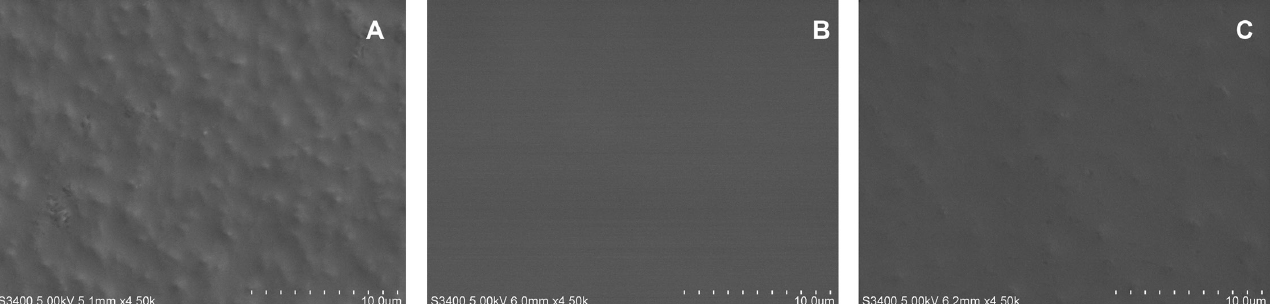
FIGURE 4 - SEM images of the surfaces of gelatin (A); chitosan (B) and gelatin/chitosan (C)